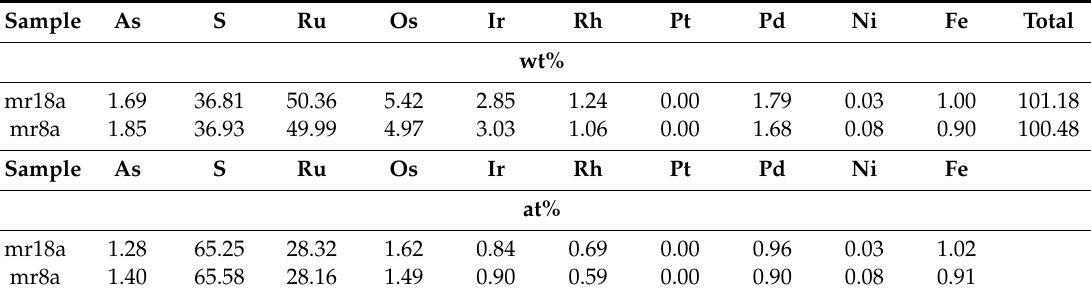
Table 1. Selected wavelength dispersive spectrometry (WDS) electron microprobe analyses of Merensky Reef laurite enclosed in chromite.